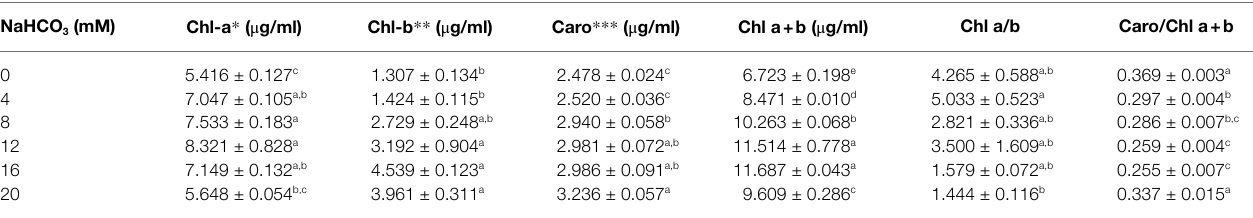
Values are mean ± SE, n = 3. Values adhered with different alphabets (a, b, c, d, and e) are statistically significant at p < 0.05.